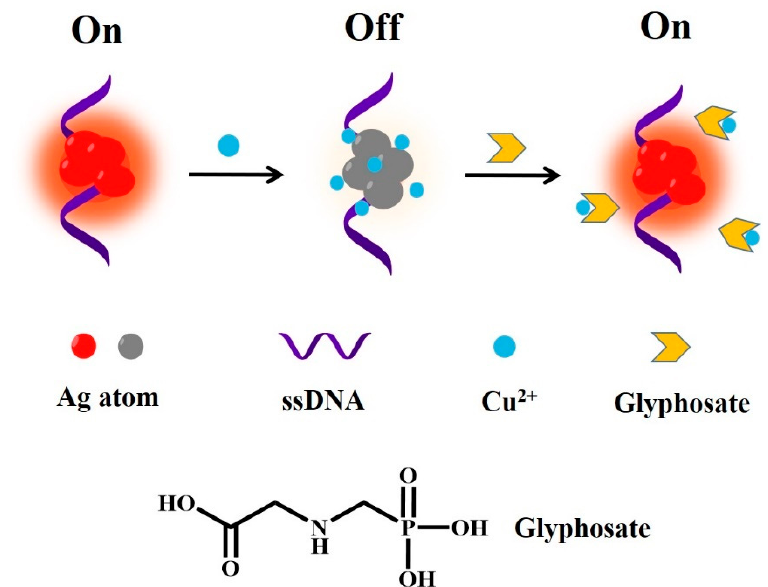
Figure 1. Schematic illustration of the detection of glyphosate based on DNA-Ag NCs.